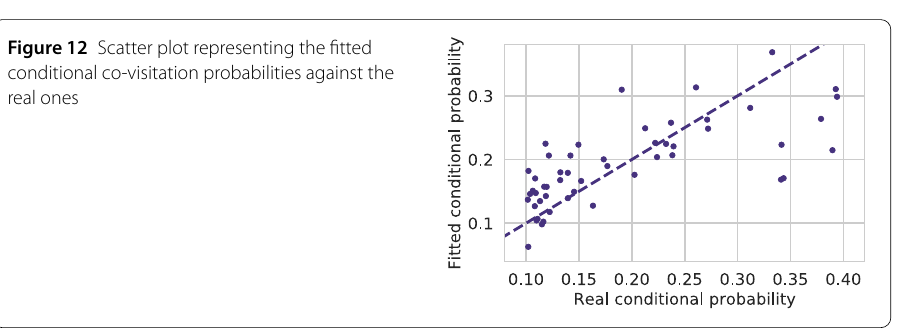
Figure 12 Scatter plot representing the fitted conditional co-visitation probabilities against the real